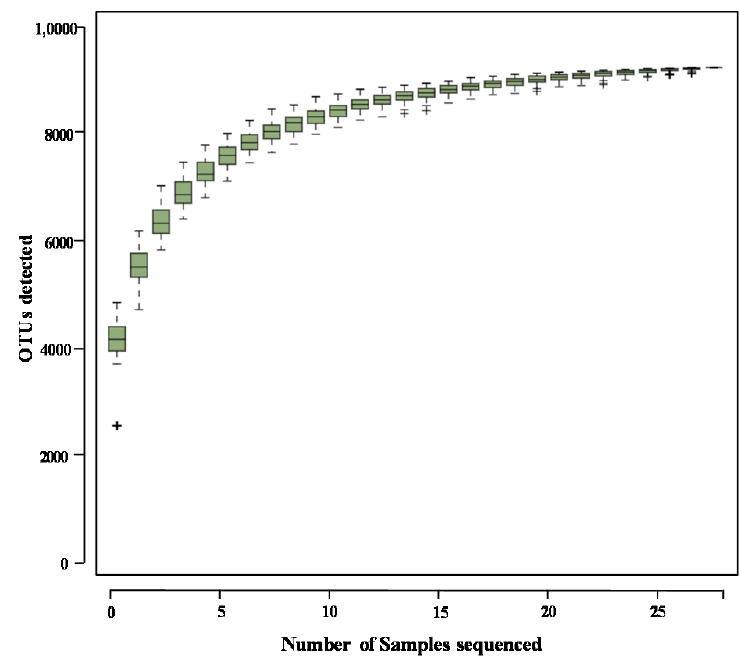
Figure 5. Species accumulation curve. The V3–V4 region of the 16S rDNA gene was sequenced from 18 samples under different treatments, resulting in a total of 776,488 high-quality sequence readings. Among the different treatment groups, the highest sequence quantity appeared in the Ic sample (Table 3; p < 0.05). There was no significant difference among the other treatment groups. Regarding different periods, all soil samples showed initially decreasing and then rising trends. Still, there were significant differences only in Ib, Ic, and IAb ( p < 0.05), which may be related to the degradation of imazapyr. The pesticides not absorbed by plants entered the soil, which provided rich nutrients for microbial growth and metabolism. Then, with the degradation of imazapyr, the number of bacteria decreased. Thereafter, the concentration of the main agent in the soil began to stabilize, the bacteria gradually formed a more stable community structure, and their number finally recovered gradually. The sequences were divided into different OTUs according to the 97% similarity threshold, and each OTU was regarded as a microbial species. The OTU classifications showed that the number of OTUs in IAb and IAc was significantly higher than that in Ic (Table 3; p < 0.05). After 30 days of treatment with different doses of adjuvant, the OTUs decreased significantly with increased doses. In addition, the effect of the herbicide can be more attributed to the death of S. alterniflora in the later stages induced by imazapyr’s inhibition of DNA synthesis, and the production of branched-chain aliphatic amino acids required for plant growth. Finally, the soil vegetation coverage and the plant rhizosphere secretion input